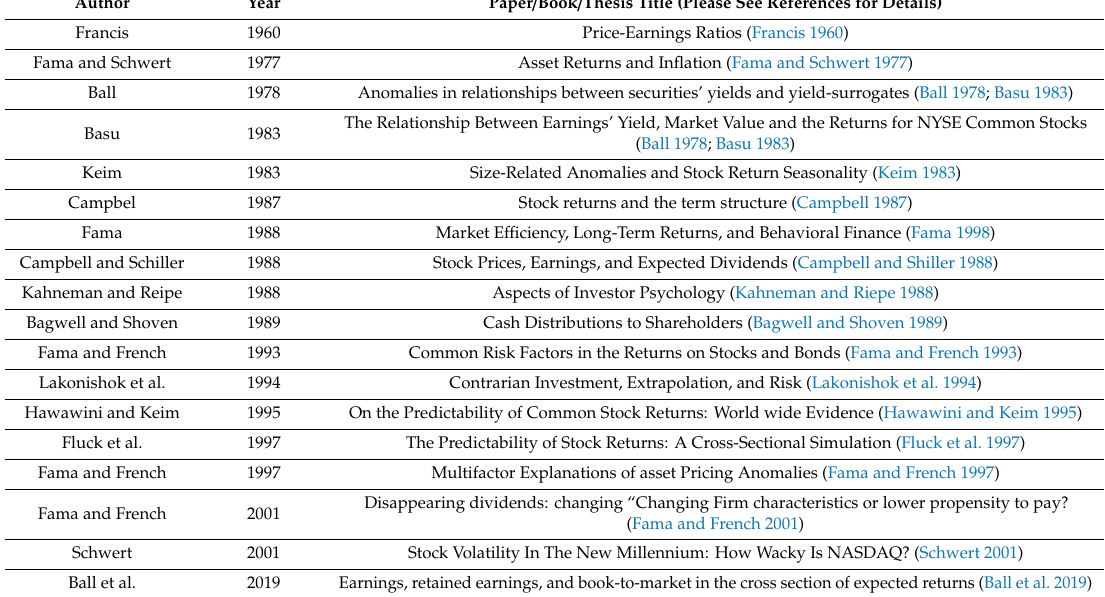
Table 3. Selected work on Early Valuation Parameters and Excess